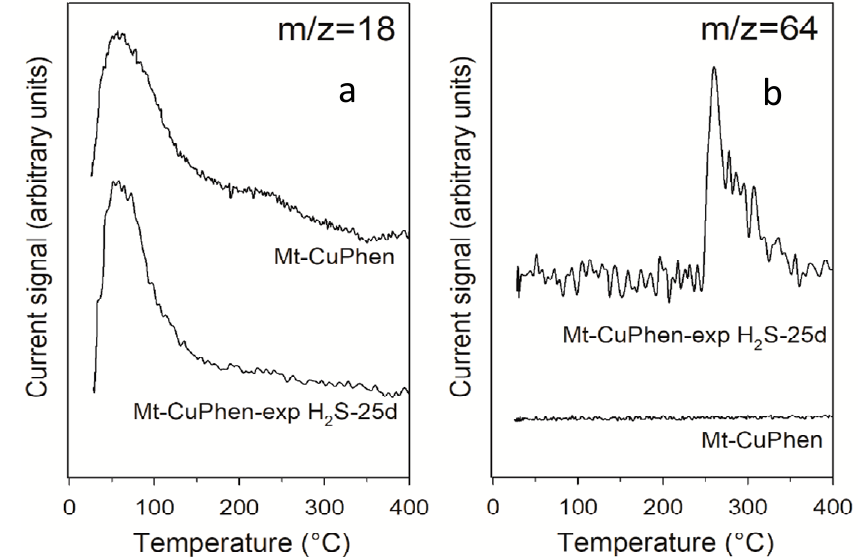
Figure 7. Tracings of gas evolved during heating for Mt-CuPhen before and after H 2 S exposure (25 d) for H 2 O ( a ) (m / z = 18) and SO 2 ( b ) (m / z =